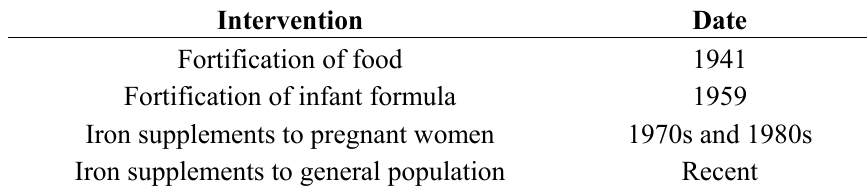
Table 1. Interventions into iron homeostasis in the United